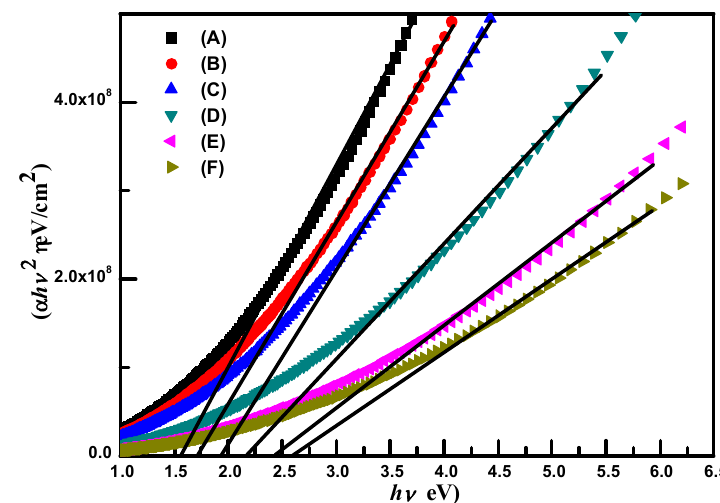
Figure 4. Plots of ( α h ν ) 2 versus incident photon energy ( hv ) for all samples. Figure 4. plots of ( α h ν ) 2 versus incident photon energy ( hv ) for all samples. The energy band gaps (Eg) of samples A–F obtained from the Figure 4 were 1.57, 1.71, 1.95, 2.16, 2.44 and 2.61 eV, respectively. They are listed in Table 2. The energy band gaps of Ag 8 SnS 6 , Ag 2 ZnSnS 4 , and ZnS were in the range of 1.28–1.39 eV [21], 2.0–2.1 eV [13,28] and around 3.6 eV [28], respectively. The energy band gap of samples A and B were located in the range between the energy band gaps of Ag 8 SnS 8 and Ag 2 ZnSnS 4 . The energy band gap of sample C approached to that for Ag 2 ZnSnS 4 reported in the literature [13,25,28]. The energy band gaps of samples D–F were larger than 2.0 eV due to their high Zn contents in the samples. Some low crystalline ZnS may be formed in the samples although it was not detected in the XRD patterns of samples D–F. Table 2. Physical properties of samples prepared in this study. E FB : flat-band potential; PEC: photoelectrochemical. Sample